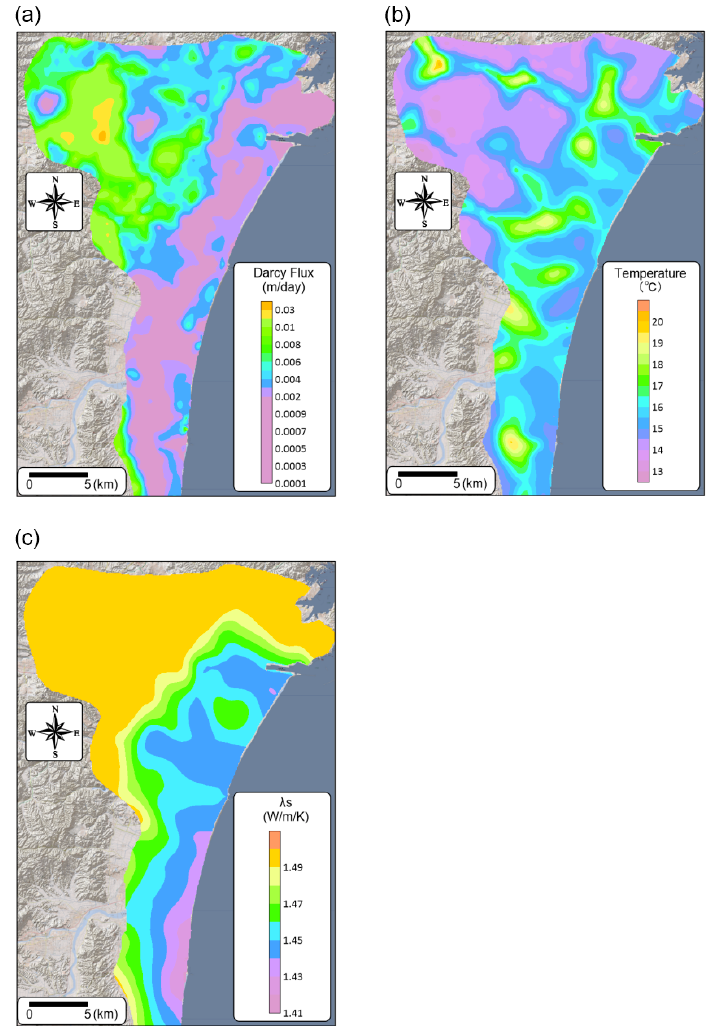
Figure 12. Distribution maps of ( a ) average groundwater flow velocity, ( b ) average subsurface temperature, and ( c ) average thermal conductivity of solids from the surface (0 m) to 100 m depth for the Sendai Plain.